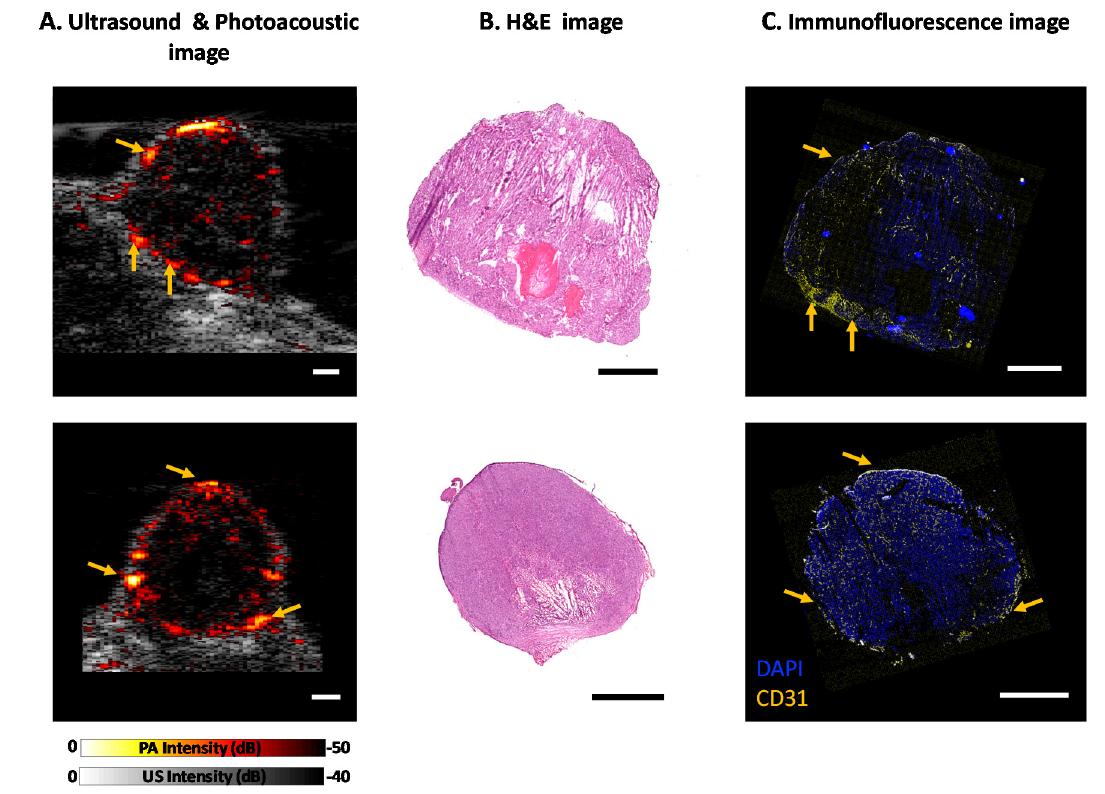
Figure 4. Evaluation of AcousticX on subcutaneous tumor xenografts in mice. ( A ) Ultrasound and photoacoustic image overlay of the tumor vasculature of two mice. Images of the Mouse 1 tumor acquired at a frame rate of 10 Hz are shown in Video 1. Motion due to breathing was minimal and only frames that did not have motion artifacts were used for image analysis. ( B ) H&E stain of the tumor cross-section. ( C ) Immunofluorescence stain for blood vessels in yellow and cell nuclei in blue. (Scale bar on all images = 2 mm, Video S1, MP4, 1.7 MB).